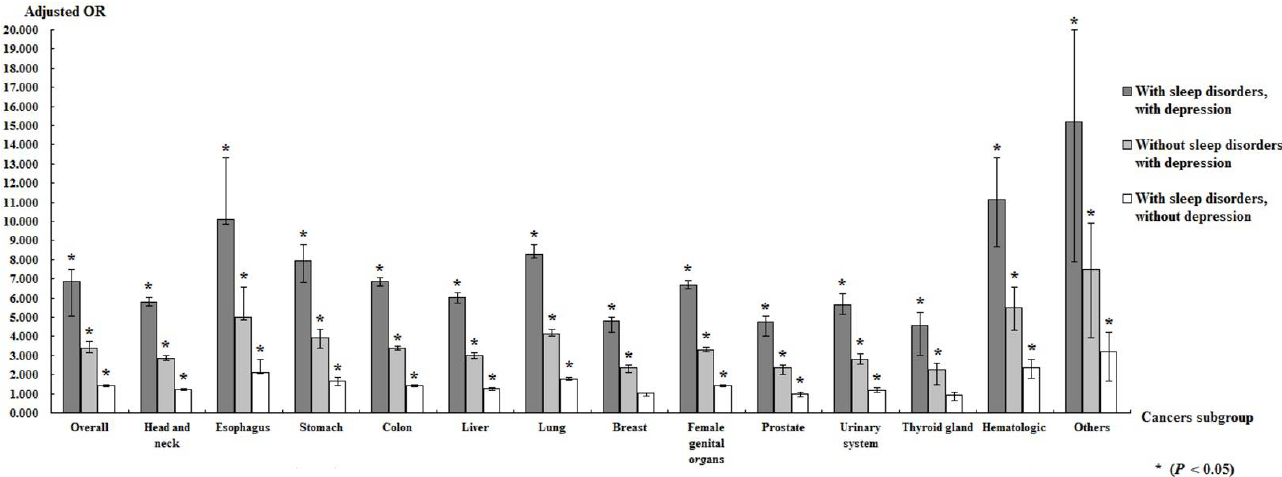
Figure 3. Subgroup analysis of specific cancer types in patients with both sleeping disorders and depression.